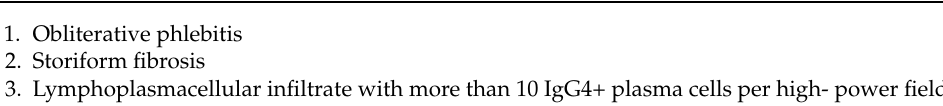
Table 7. Histopathological criteria for IgG4-related sclerosing cholangitis (created in accordance with Deshpande et al. [66]).